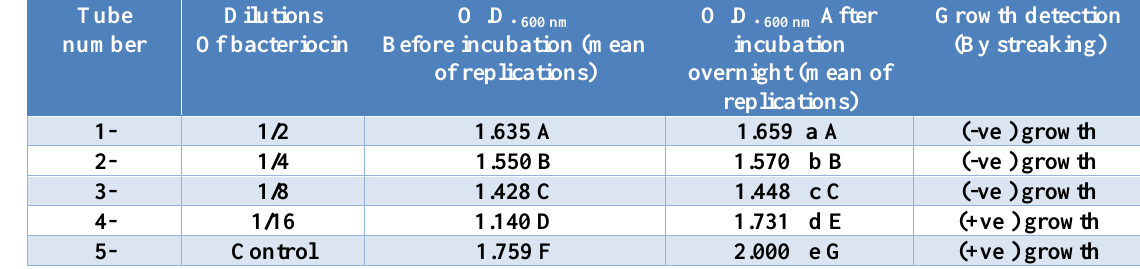
Different small letters in a column revealed significant differences (P˂0.05) between dilutions factor of bacteriocin. Horizontal different capital letters revealed significant differences (P˂0.05) between dilutions of